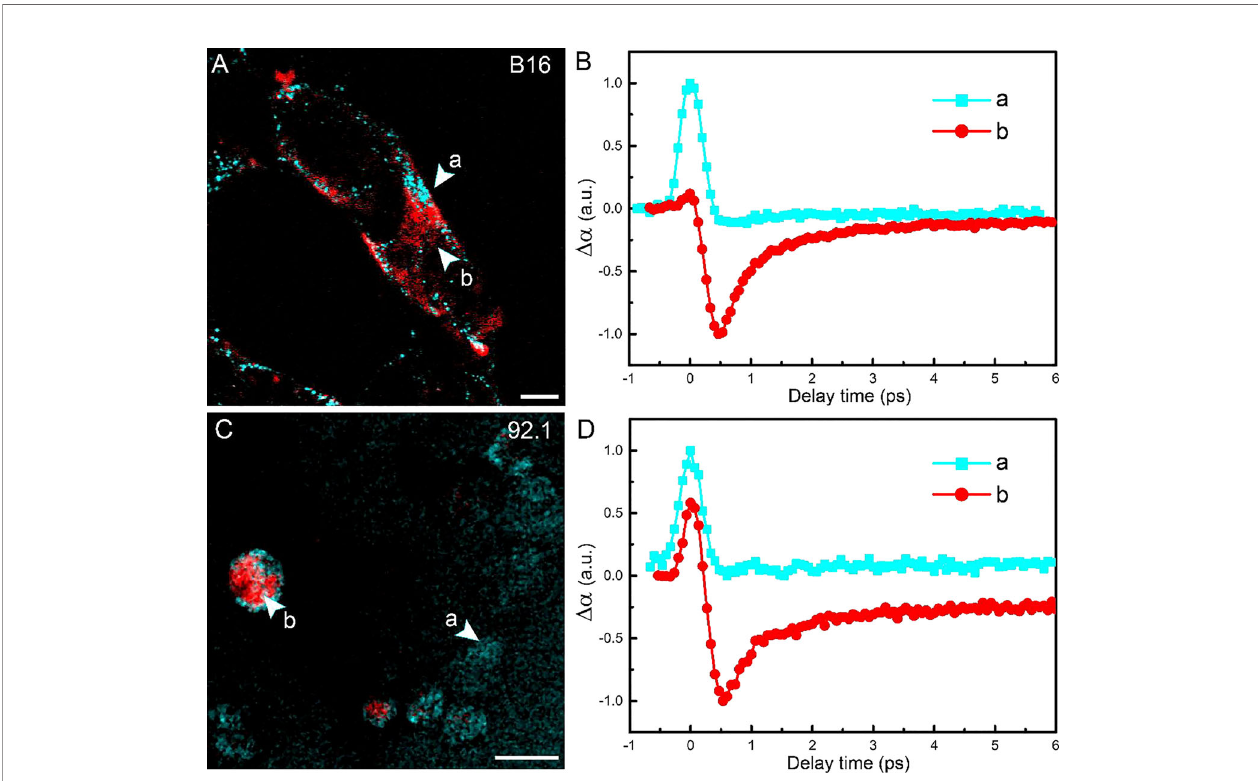
FIGURE 5 | Imaging melanoma cell lines. (A) Pump-probe imaging of B16 cells. (B) Transient absorption dynamics of intracellular pheomelanin (a) and eumelanin (b). (C) Pump-probe imaging of B16 cells. (D) Transient absorption dynamics of the melanin species. Red: eumelanin; cyan: pheomelanin. Scale bar: 10 m